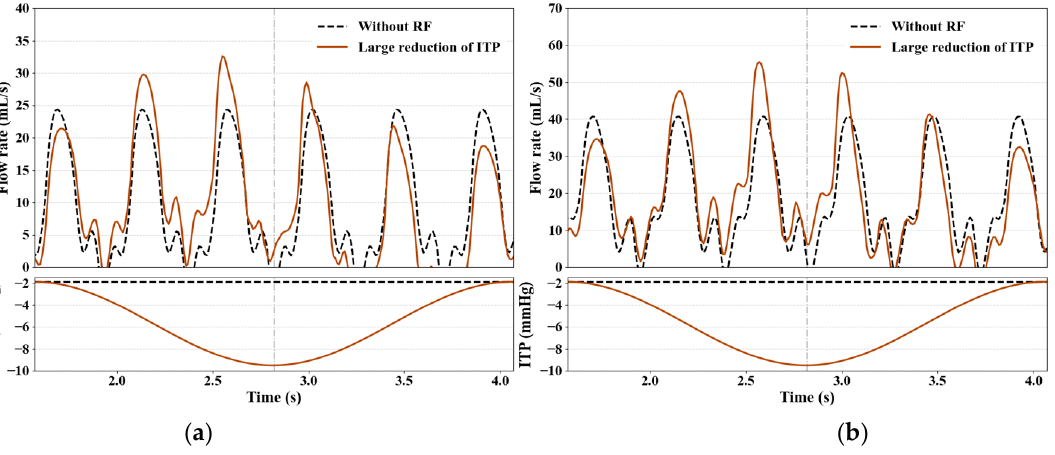
Figure 10. Impact of large ITP reduction on flow rates in SVC ( a ) and IVC ( b ) associated with an infant subject.